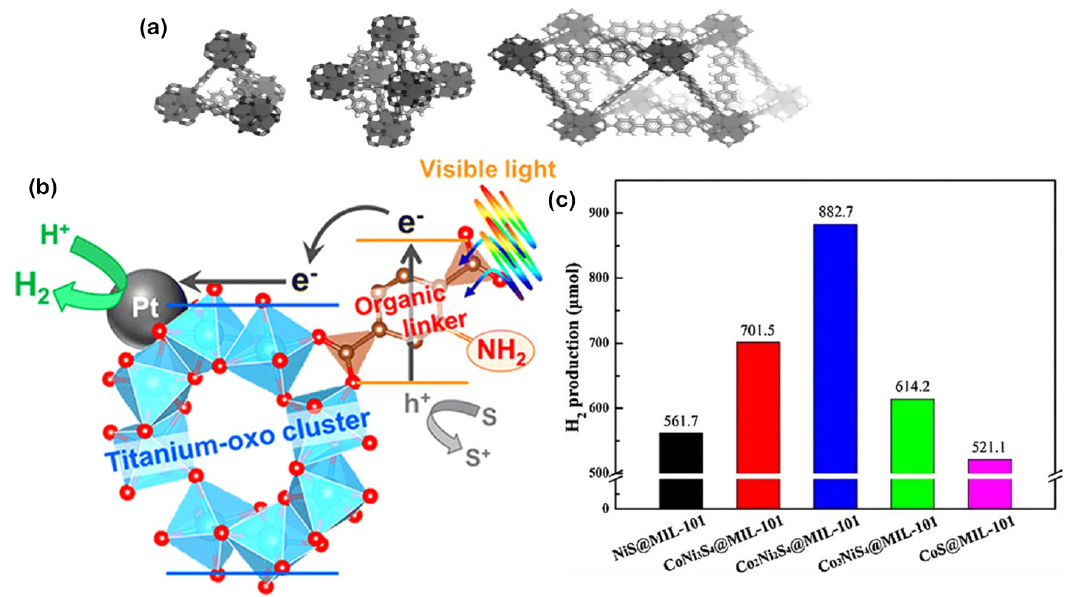
Figure 19. ( a ) Crystal structure of UiO-66. Reproduced with permission from reference [258,261]. Copyright 2018, American Chemical Society and 2010, Wiley-VCH, respectively. ( b ) Schematic illustration of H 2 generation in amino-functionalized titanium (IV) MOF. Reproduced with permission from reference [259]. Copyright 2017, Elsevier. ( c ) Hydrogen evolution reaction in